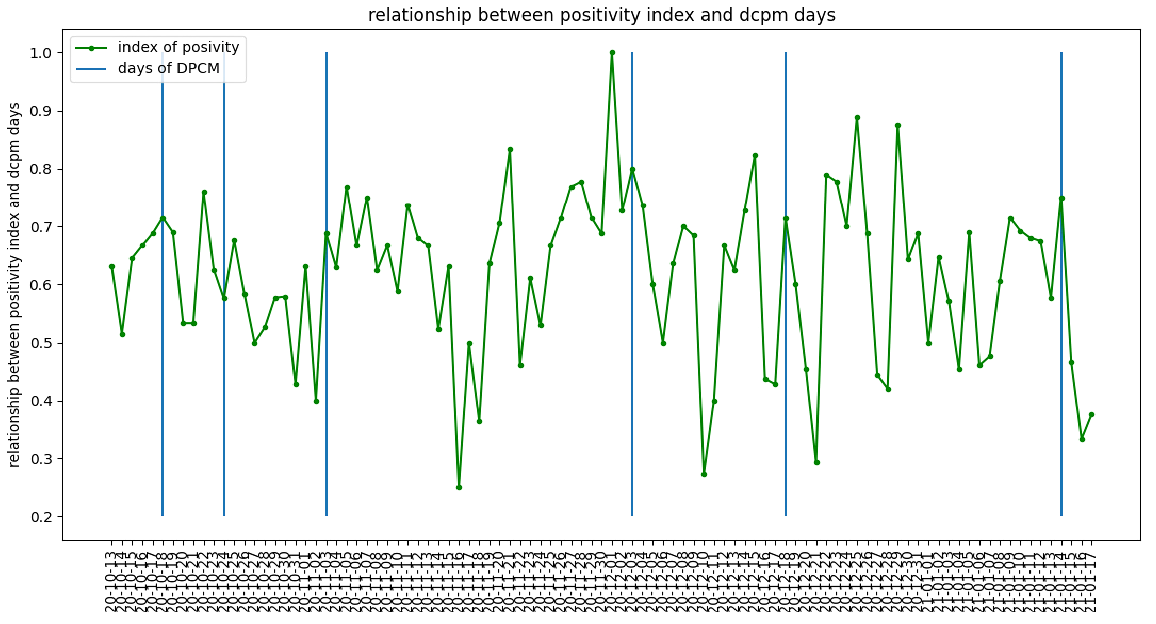
Figure 10. Positive index and days in which the DPCM were signed.